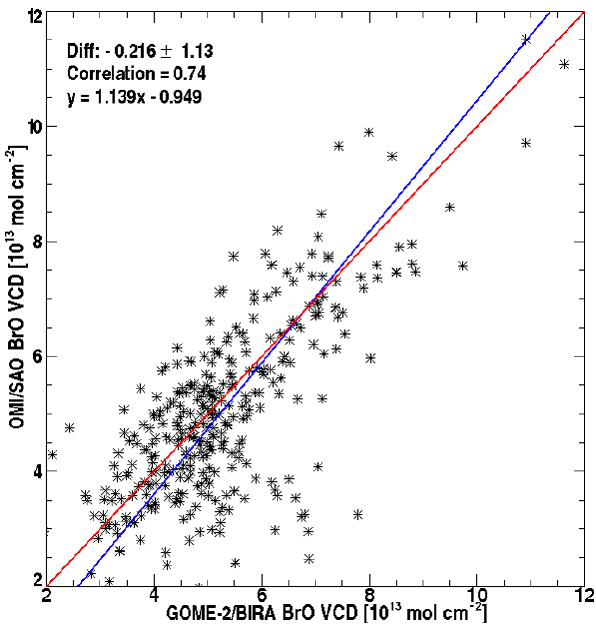
Figure 6. Correlation and orthogonal regression of OMI and GOME-2 BrO for the data shown in Fig. 5. The legends show the mean bias and standard deviation of the differences, correlation and the orthogonal